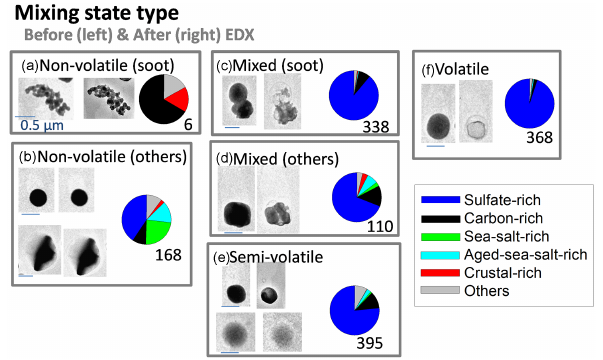
Figure 9. Classification of mixing states based on the comparison of electron micrographs for individual particles before (left) and af- ter (right) irradiation by an electron beam: type a, non-volatile soot particles; type b, non-volatile particles except soot; type c, mixed particles of volatile material and non-volatile soot aggregate; type d, mixed particles of volatile material and non-volatile core without a soot-like shape; type e, semi-volatile particles; and type f, volatile particles. The pie chart in each mixing state type a–f represents the number fraction of compositional types determined by EDS analy- sis.